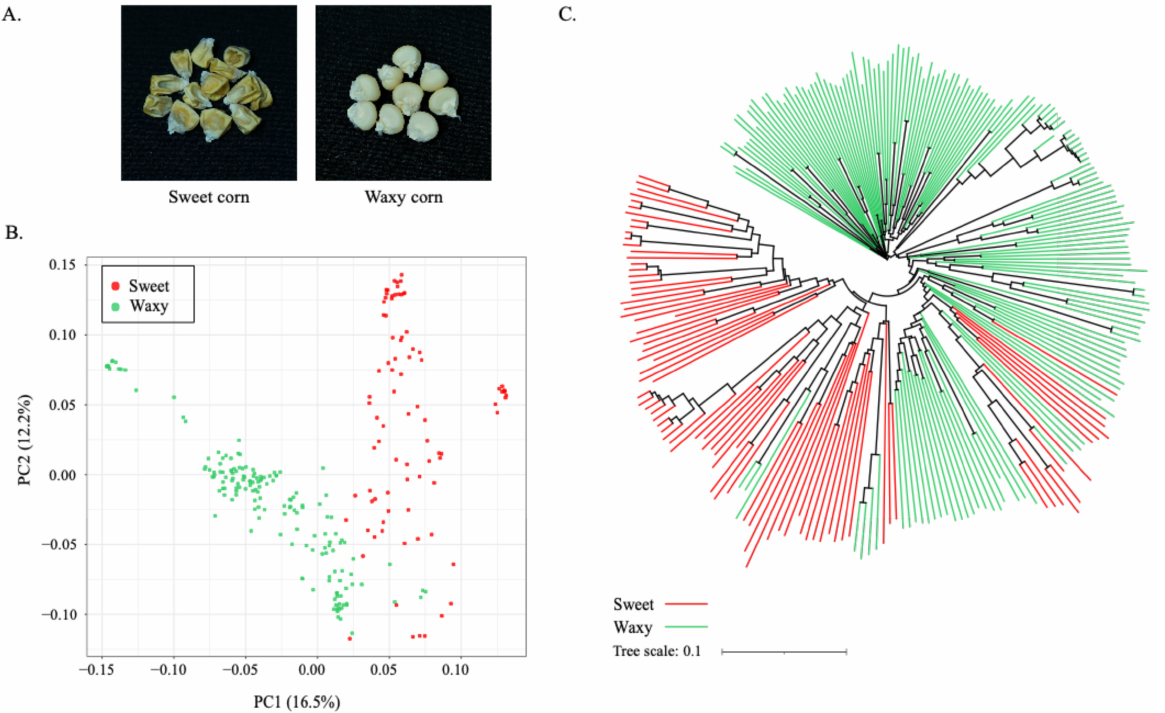
Figure 1. Genetic structure of 250 sweet- and waxy-corn lines. ( A ) Appearance of kernel structures that was used as a criterion to assign maize lines as sweet corn and waxy corn. ( B ) Principal-component analysis plots based on 159,201 SNP markers; ( C ) phylogenetic-tree clustering based on 159,201 SNP markers. The waxy corn and sweet corn accessions in ( B , C ) are shown in green and red,